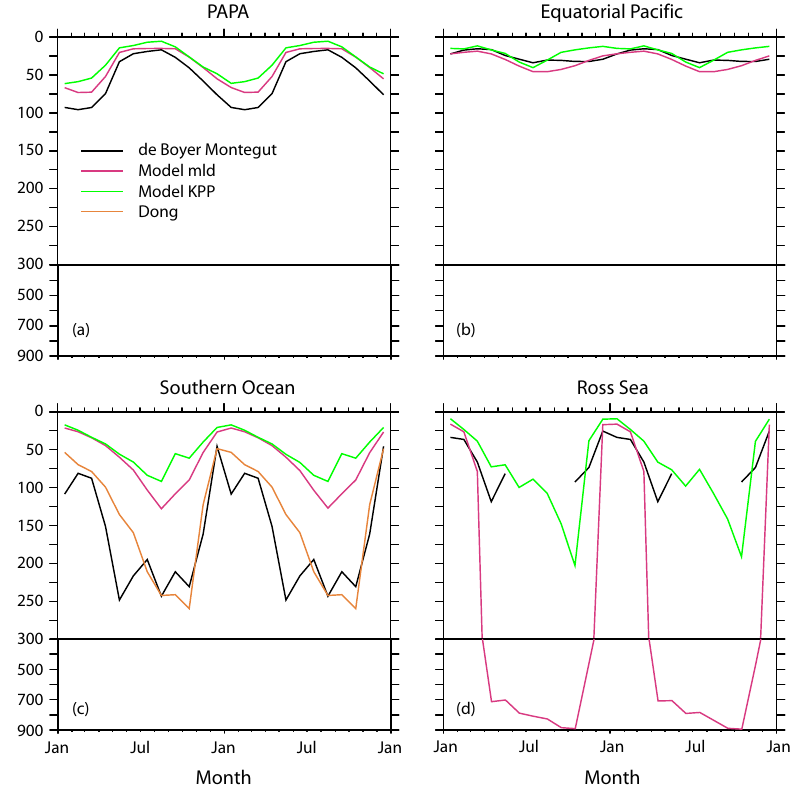
Fig. 4. Mixed layer depths determined from observations by de Boyer Mont´egut et al. (2004) at all four fertilization sites and Dong et al. (2008) at the Southern Ocean fertilization site. The de Boyer Mont´egut et al. (2004) mixed layer depths are determined by averaging together estimates of the mixed layer depth calculated from individual temperature profiles using a temperature criterion of 1 T = 0.2 ◦ C referenced to the value at 10m depth. Dong et al. (2008) use potential density calculated from Argo float data and only provide estimates for the Southern Ocean region. Two versions of the model mixed layer depths are shown using (1) a buoyancy criterion of 0.0003ms − 2 (“Model mld”) and (2) the KPP mixed layer depth (“Model KPP”) as defined in Appendix B and shown in Fig.